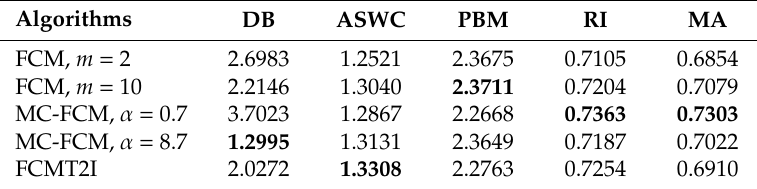
Table 6. Experimental results with the WINE dataset, 178 samples, 3 clusters, m L = 1.1, m U =